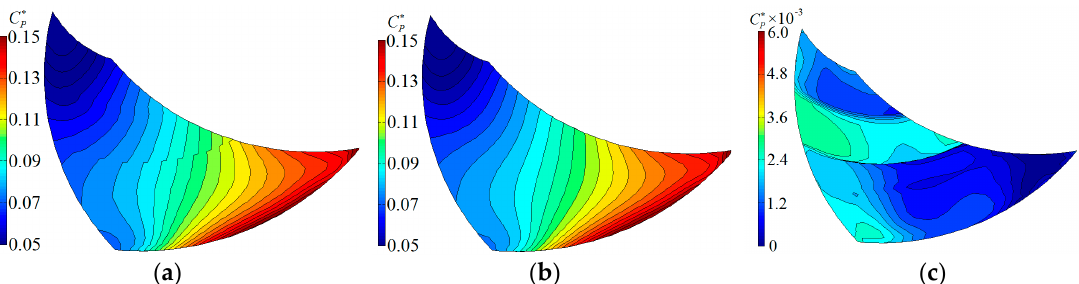
Figure 10. Computational fluid dynamics (CFD) calculation, proper orthogonal decomposition (POD) reconstruction and their error of pressure fluctuation intensity on the single channel plane. ( a ) POD reconstruction; ( b ) CFD calculation; ( c ) Error.